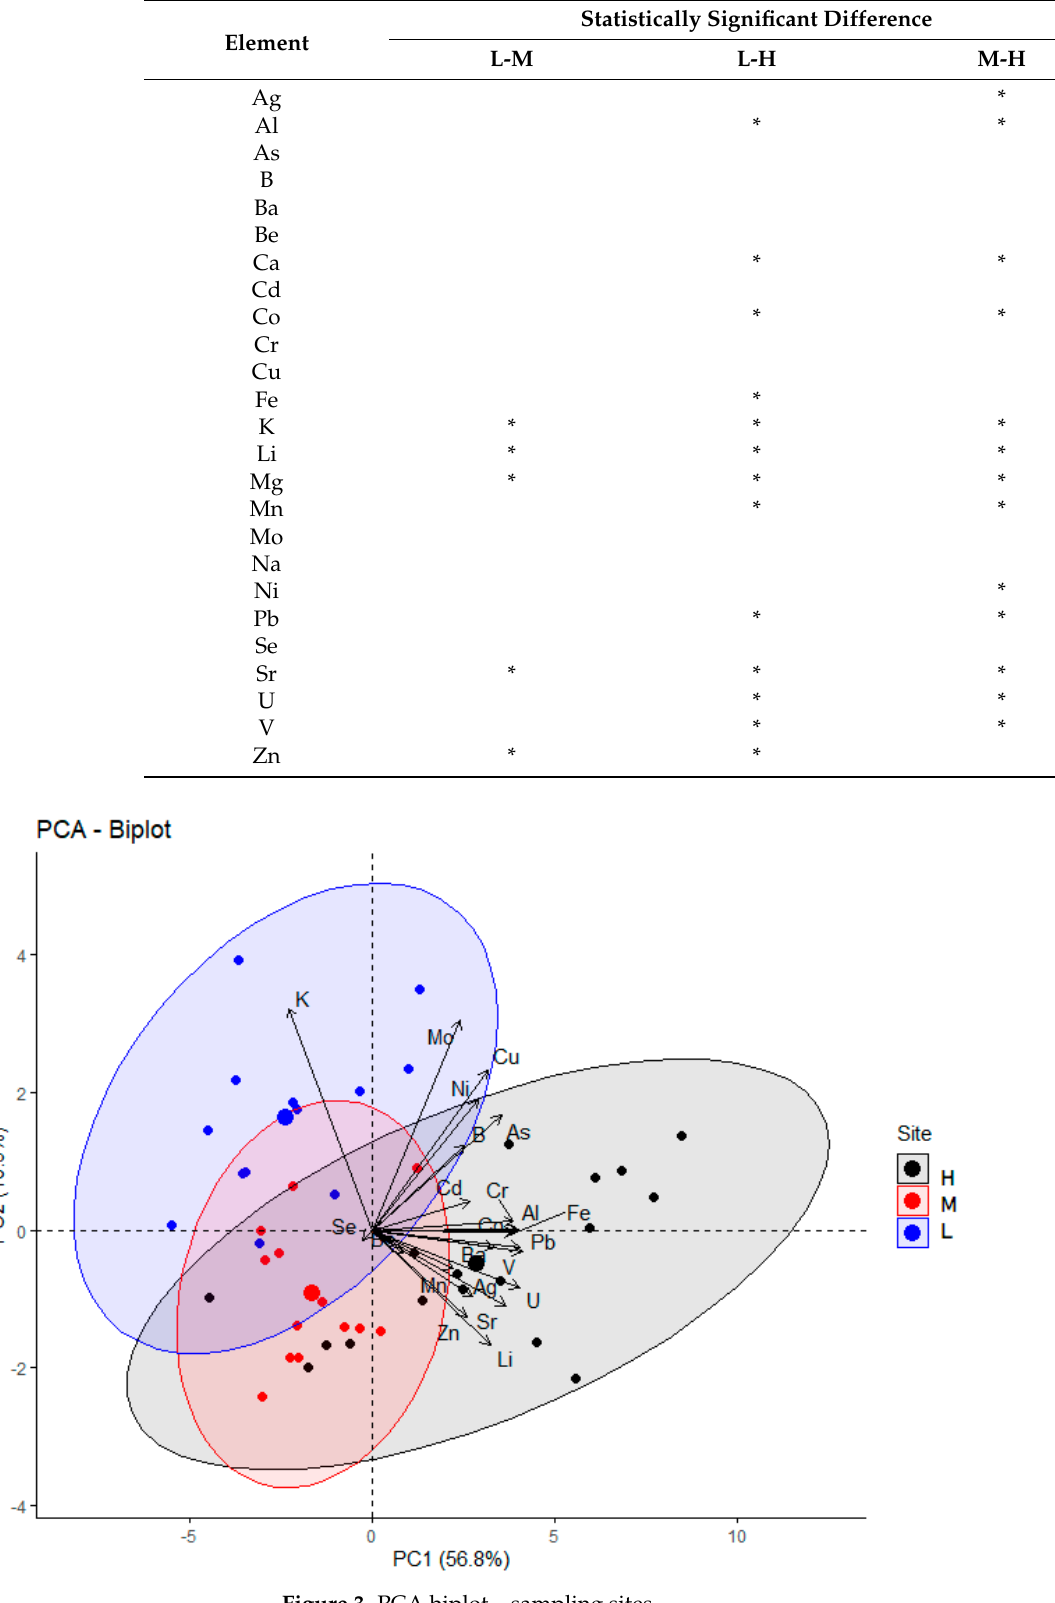
Figure 3. PCA biplot—sampling sites. Table 2. Statistically significant differences in elemental content in the dried needle samples be- tween the sampling sites when the respective site combination is marked with *.